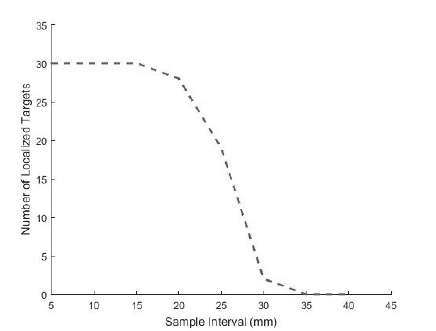
Figure 7. Relationship between the sample intervals and the number of the localizable targets the background color is set to white. Figure 8 shows the generated orthoimages of a typical target from point clouds with different sample